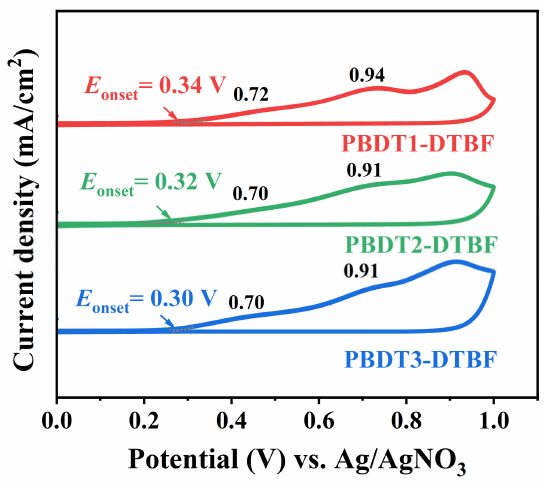
Figure 3. Cyclic voltammetric curve of the polymer PBDT1-DTBF, PBDT2-DTBF and PBDT3-DTBF, with a scan rate: 50